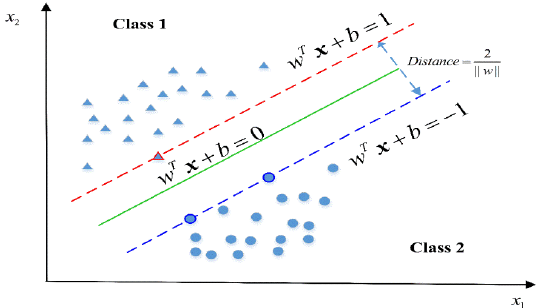
Figure 2. A demonstration of the support vector machine (SVM) for classification.